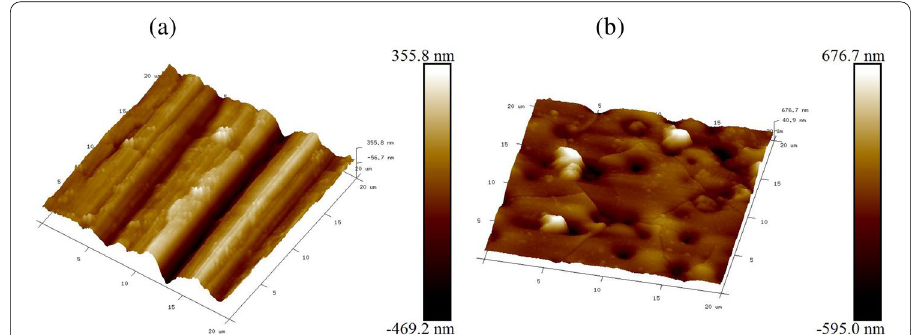
Fig. 7 AFM of the alloy after surface treatment with a S3 and b S4 treatment with conversion in